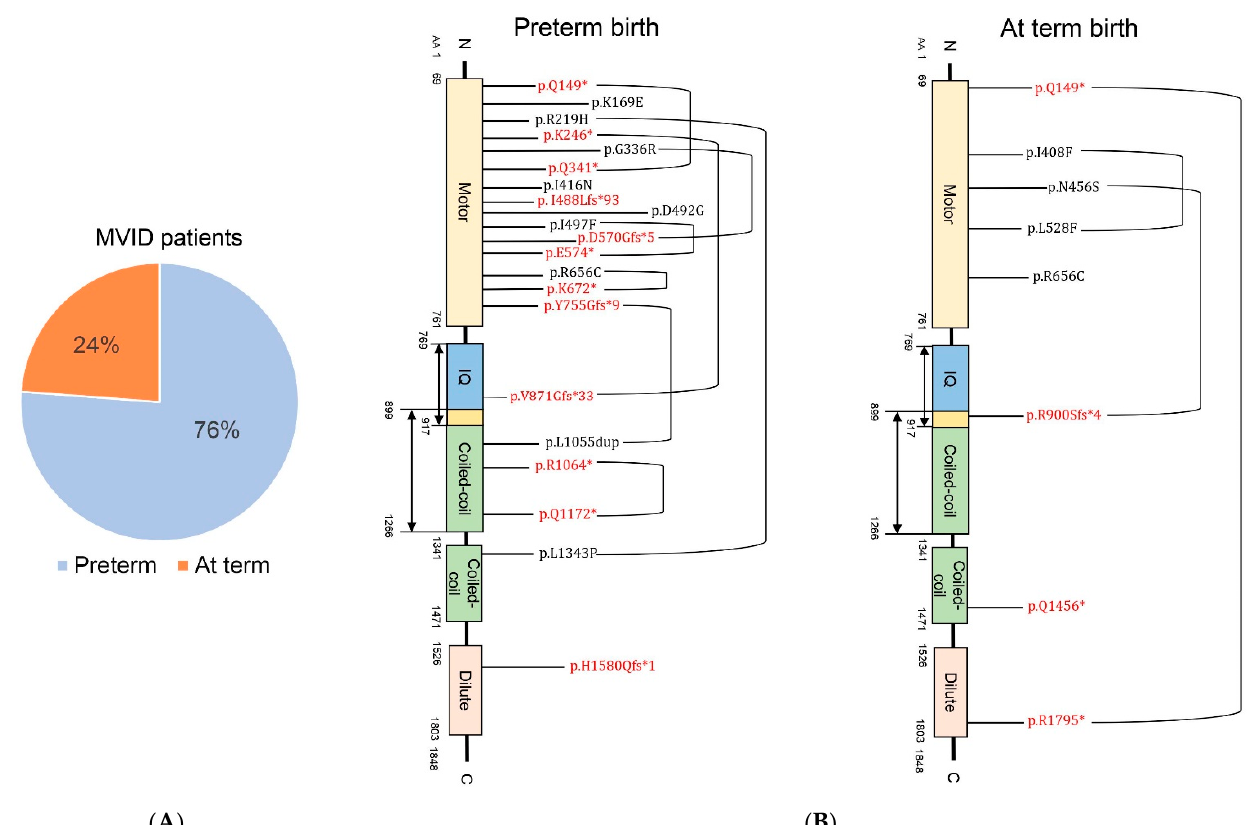
Figure 2. Relationship between MYO5B mutations and preterm birth in MVID. ( A ) Pie chart showing the percentage of preterm (blue) and at term (orange) births in cases of MVID associated with biallelic MYO5B mutations. ( B ) MYO5B mutations associated with preterm and at term births in MVID and the position of these mutation in the myosin Vb protein. Mutations that give rise to a premature termination codon are shown in red; other mutations are shown in black. Brackets connecting mutations indicate that these mutations were identified in the same patient. The absence of a bracket indicates a homozygous mutation. Asterisks indicate premature truncation of the